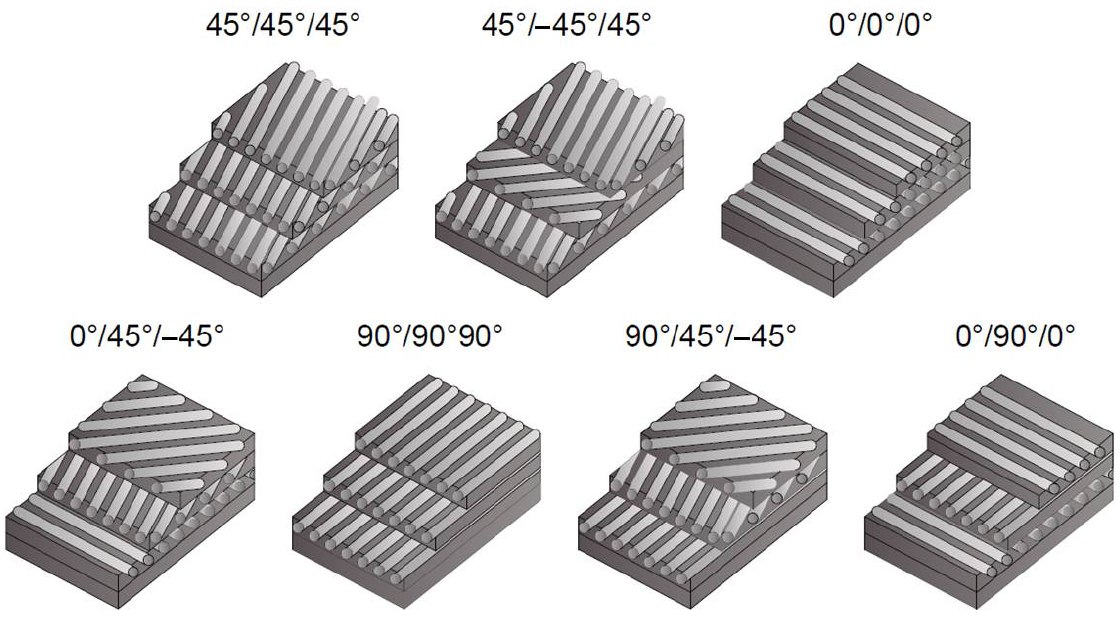
Figure 5 . Different orientations of carbon fibres in composite manufactured from three CFRP laminates, adapted from [36]. Table 3 . Cutting force based on fibre angle, adapted from [34] .